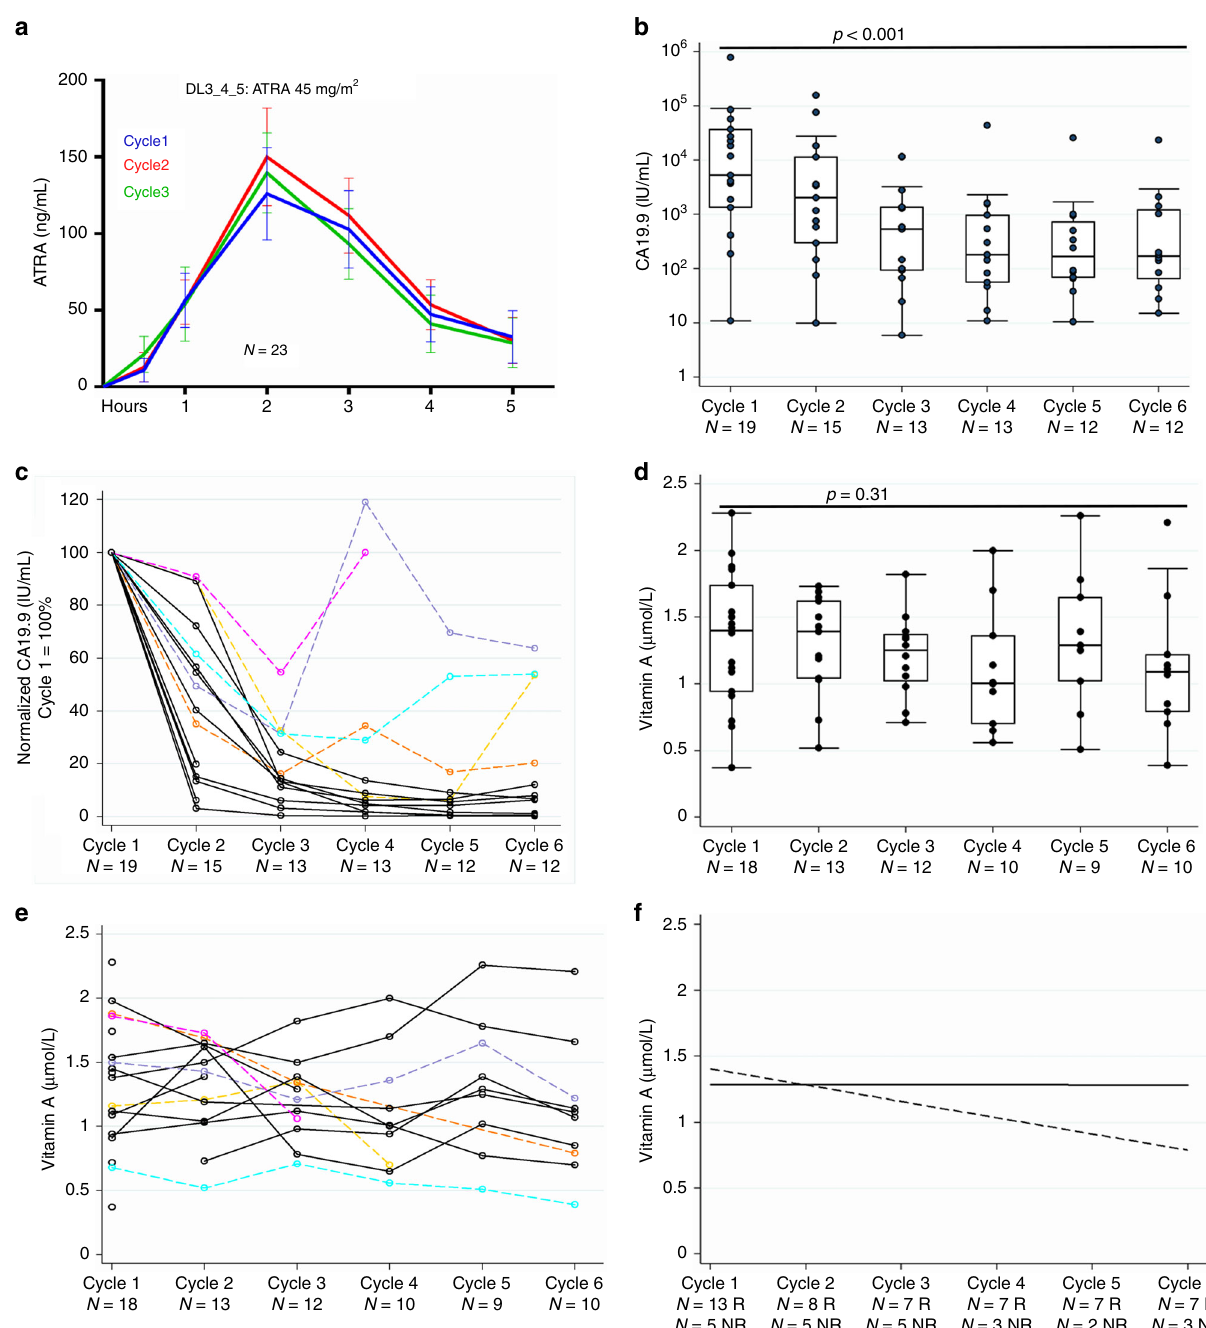
Fig. 3 ATRA pharmacokinetics, biochemical CA19-9 response and vitamin A levels. a Serum ATRA levels for the fi rst three cycles are summarized as mean (SEM) for the fi rst 5 h after co-administration of ATRA at 45 mg/m 2 with chemotherapy drugs. b Absolute CA19-9 levels on logarithmic Y -axis for patients on dose level 5 at start of each cycle. Summary statistics represented by box (median ± interquartile range) and whisker (range: LQR − (1.5 × IQR) and UQR + (1.5 × IQR)). Two-sided Skilling – Mack test, statistic 39.21, p < 0.001. c Normalized CA19-9 levels for each patient on dose level 5 with baseline being 100%. There were 14 biochemical responders (black) compared to 5 non-responders (unique colors). Responders are de fi ned as those who show >30% reduction of CA19-9 from baseline with a sustained response (no greater than 20% rise from previous reading at any time). d Vitamin A on dose level 5 at start of each cycle. Summary statistics represented by box (median ± interquartile range) and whisker (range: LQR − (1.5 × IQR) and UQR + (1.5 × IQR)). Two-sided Skilling – Mack test, statistic 5.95, p = 0.31. e Individual values for vitamin A for patients with biochemical non-responders (CA19-9) highlighted in corresponding colors as in panel c . f Linear regression trend lines comparing biochemical responders (solid line) to non-responders (dashed line) demonstrate that a drop in serum vitamin A levels may indicate non-responders. N = X R: X is the number of responders at the stated cycle. N = X NR: X is the number of non-responders at the stated